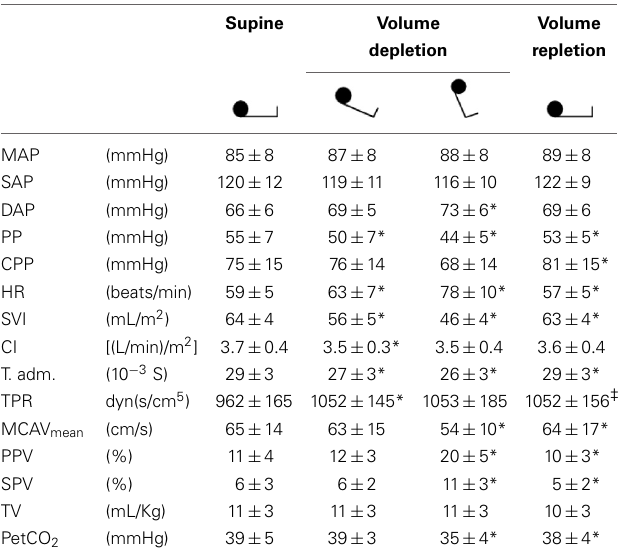
Table 1 | Effect of tilt on measured parameters.